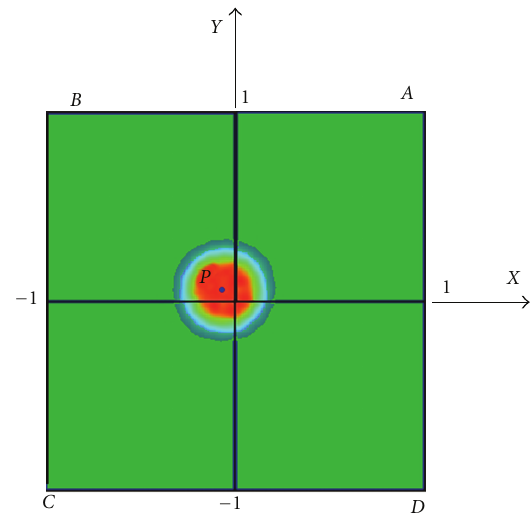
Figure 8: 4 Q -detector with sun’s